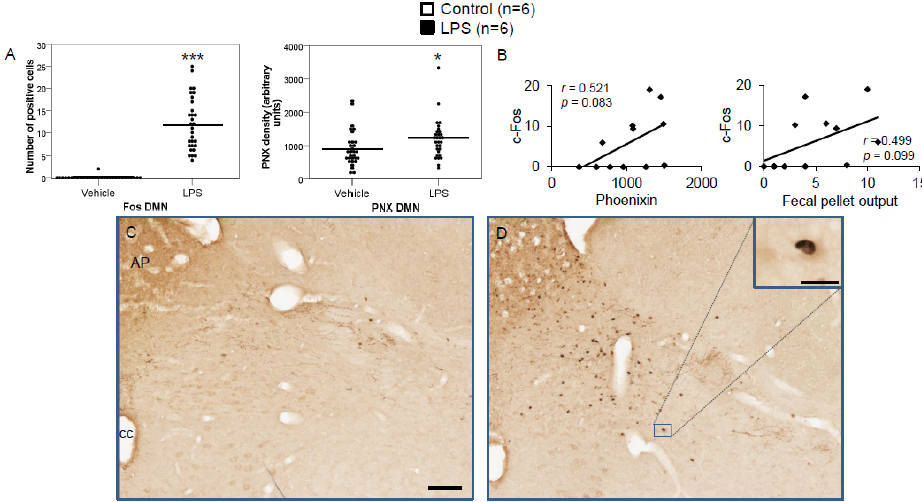
Figure 7. LPS stimulates c-Fos and phoenixin expression in the dorsal motor nucleus of the vagus nerve. Ad libitum-fed rats were subjected to IP injection of LPS or control, and 180 min after the injection, brains were processed for c-Fos and phoenixin double-immunohistochemistry. LPS stress significantly increased the number of c-Fos-positive cells and increased phoenixin expression in the DMN ( A ). A non-significant correlation was observed between c-Fos and phoenixin immunoreactivity in the DMN ( B ), as well as c-Fos and fecal pellet ( B ). Representative pictures of the evaluated slides are shown in ( C ) (control) and ( D ) (LPS). The scale bar represents 100 μ m in the overview and 20 μ m in the insert. Data are expressed as individual data points (5/animal) and mean in ( A ). Mean values per animal are plotted in ( B ). * p < 0.05 and *** p < 0.001. Abbreviations: AP, area postrema; cc, central canal.